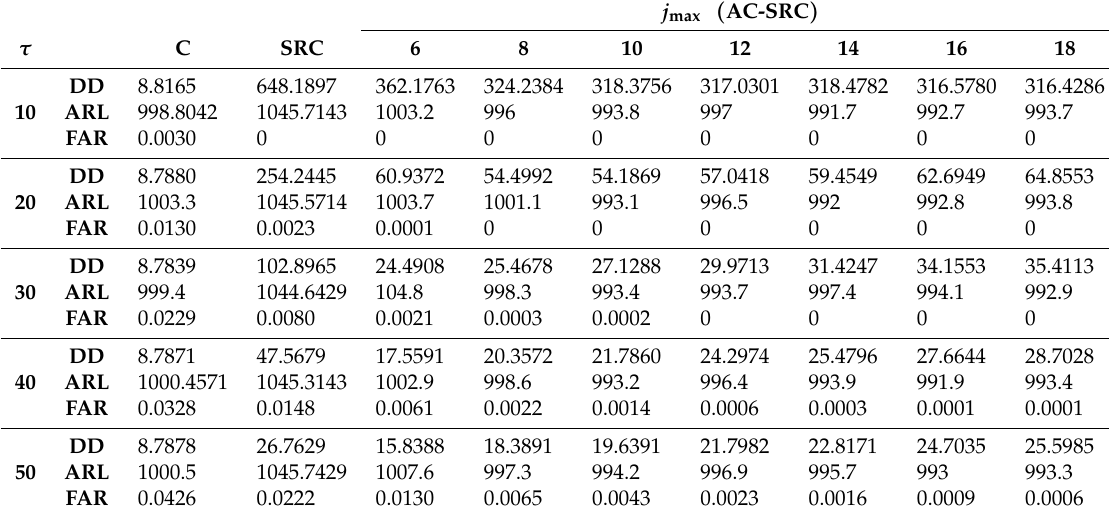
Table 4. ARL 0 = 1000, 0%